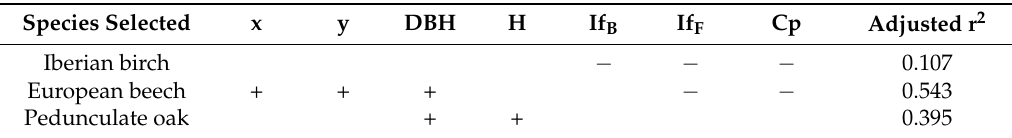
Table 4. Selected multiple regression models of tree growth for the 1977–2007 common period and the three